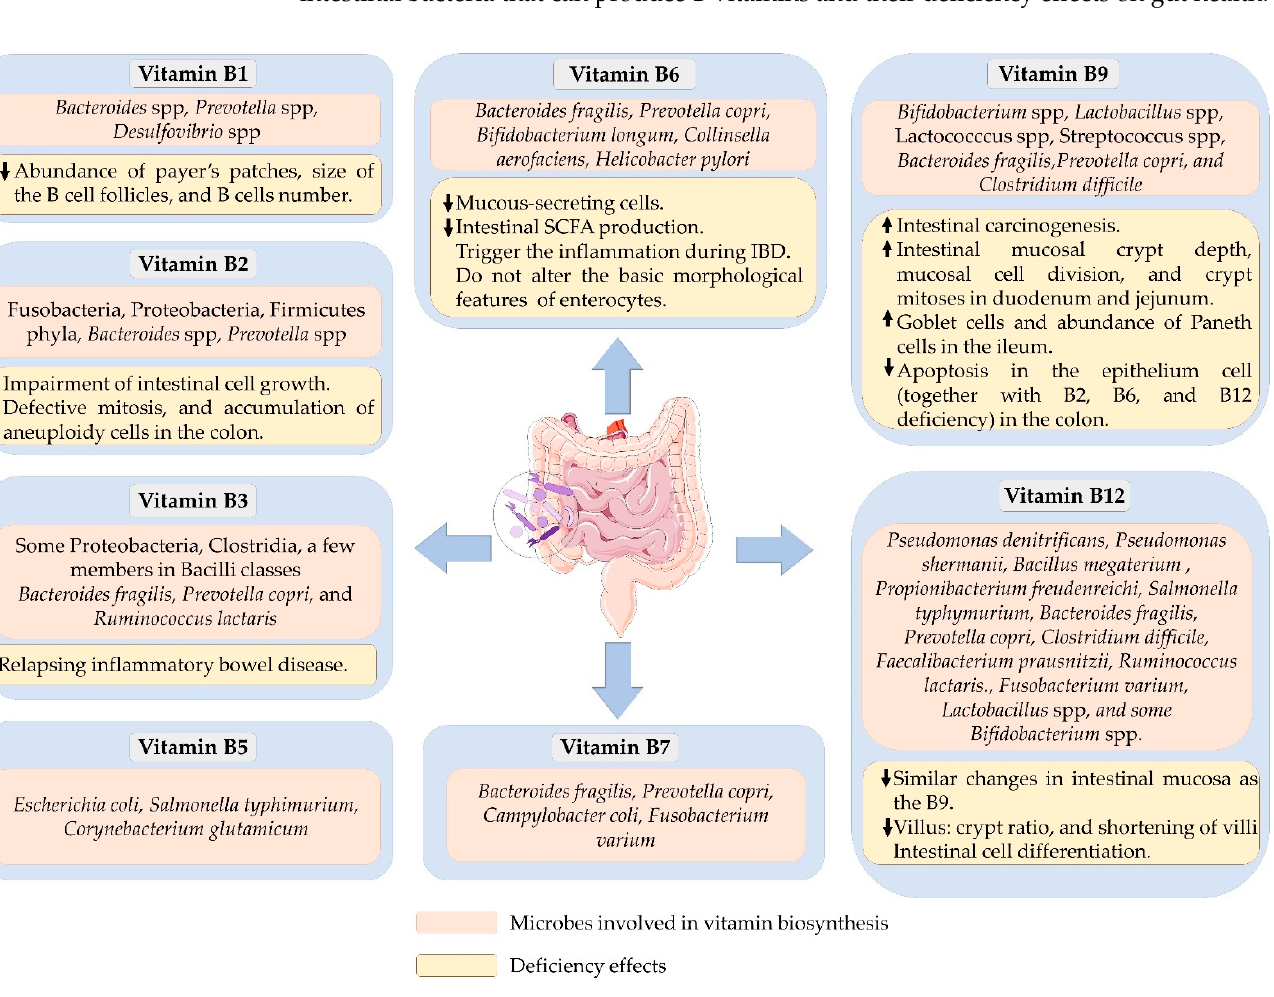
Figure 1. A schematic illustration listing the bacteria that can synthesize B vitamins and the effects of B vitamin deficiencies on gut health. B vitamin deficiencies on gut